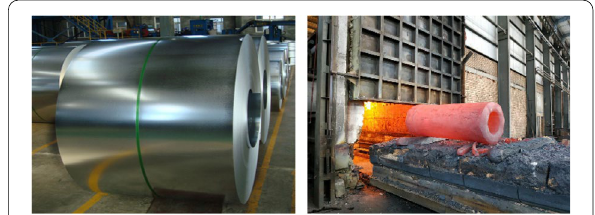
Figure 1 Large parts in nuclear power equipment